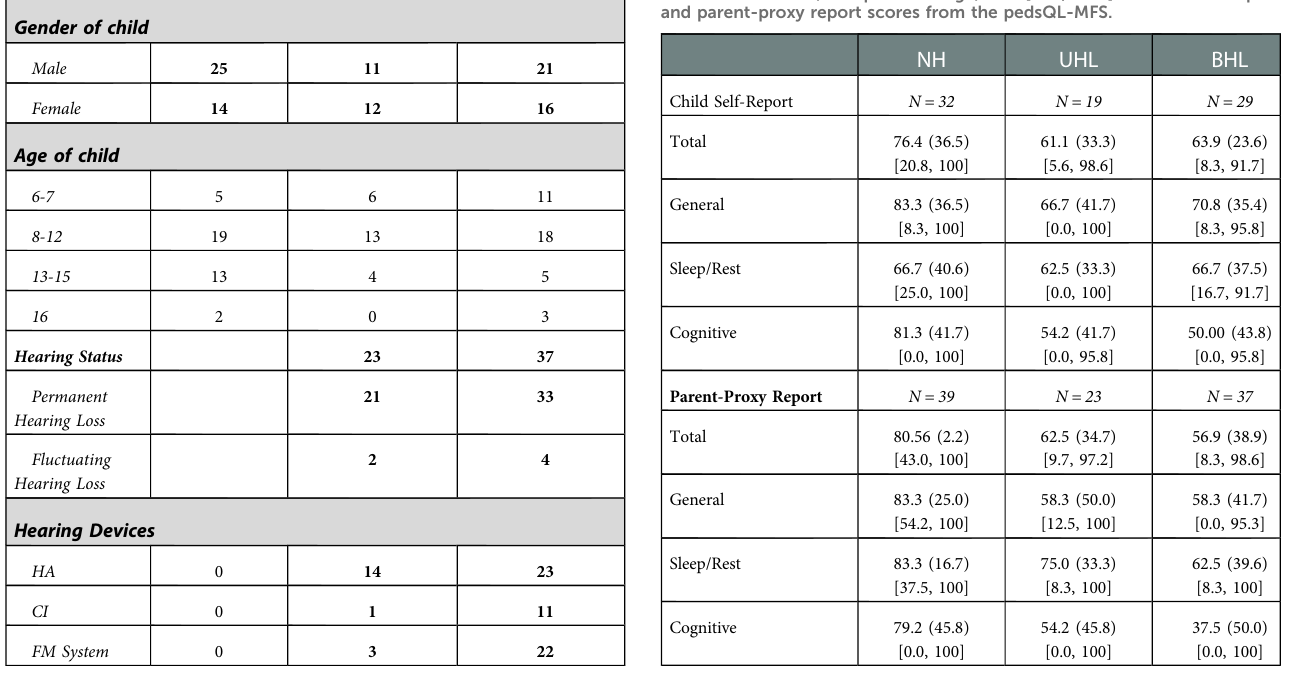
TABLE 1 Demographics include 99 cases where the parent fi lled out the questionnaires. HA; hearing aids, CI; cochlear implants. Normal Hearing